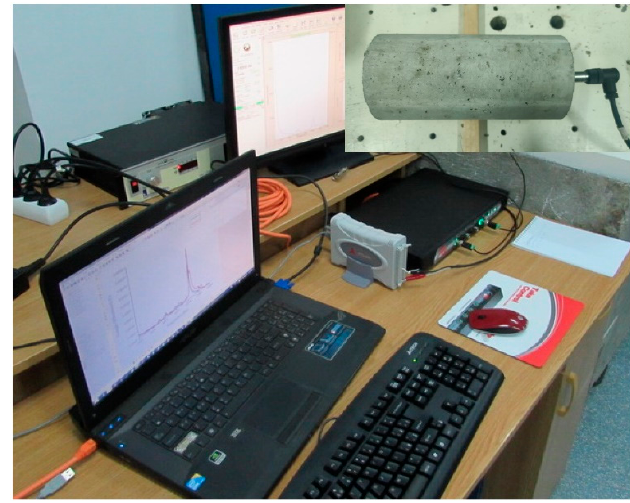
Figure 4. Assessment of the dynamic modulus of elasticity.